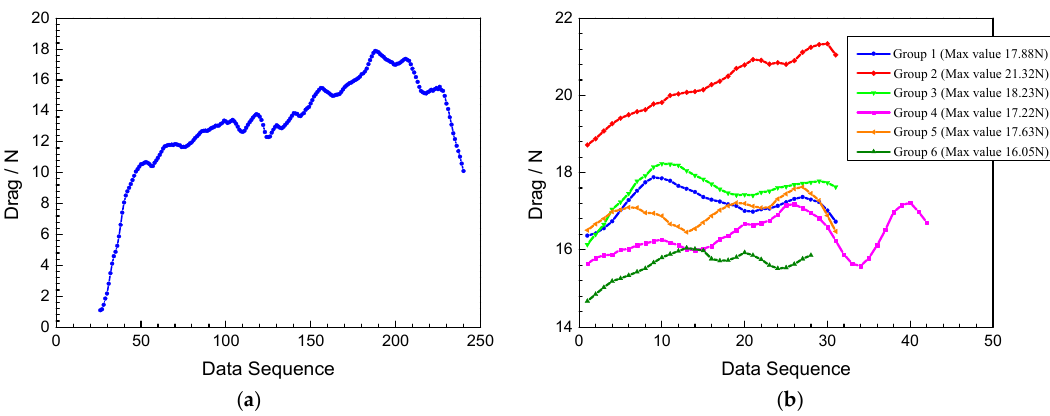
Figure 10. Drag results of the completion string with a packer in the deviated section with lots of sand: ( a ) A typical drag curve of the whole moving process; and ( b ) six groups of drag section near the maximum value of the drag curve.